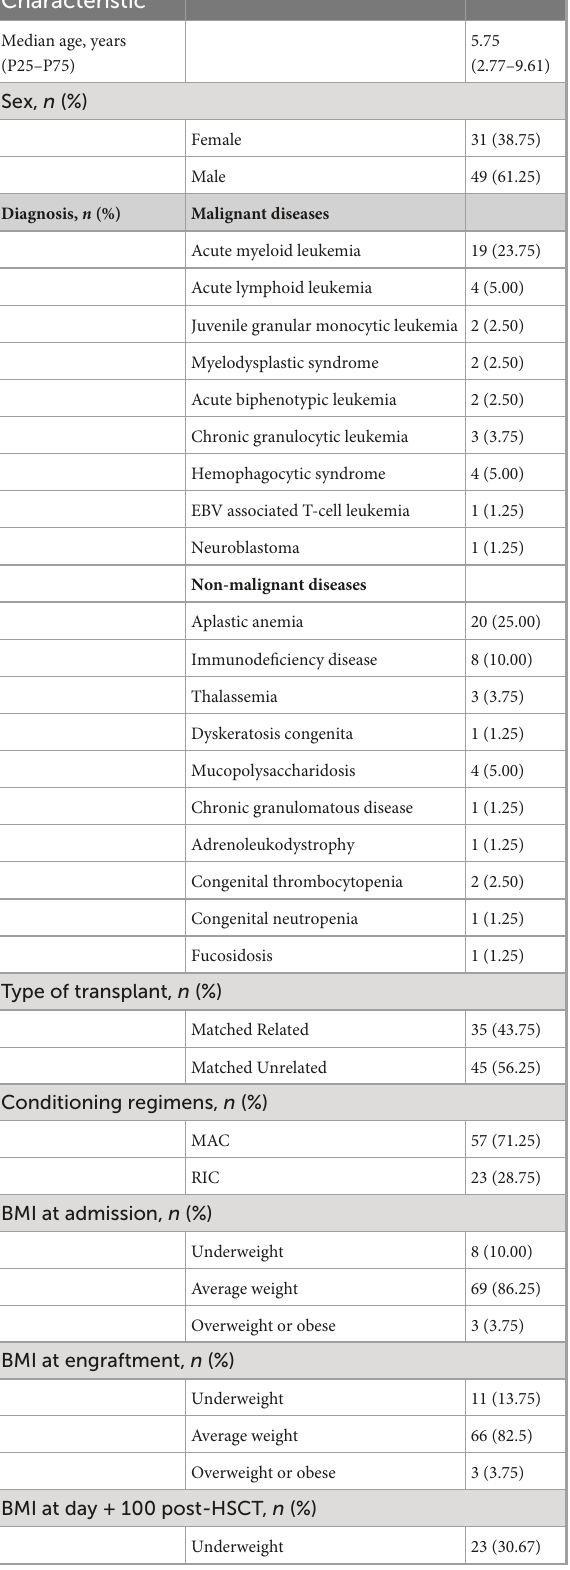
TABLE 1 Characteristics of child participants in the study.